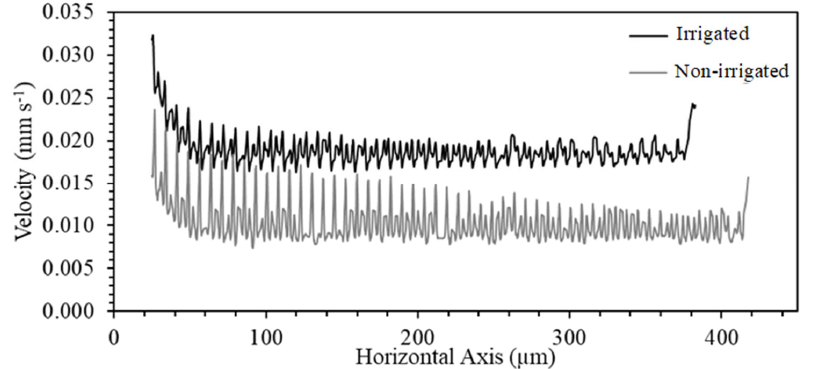
Figure 10. Numerical predictions of flow velocity generated along with the anatomical model in the longitudinal section of irrigated and non ‐ irrigated Khaya grandifoliola xylem vessels.